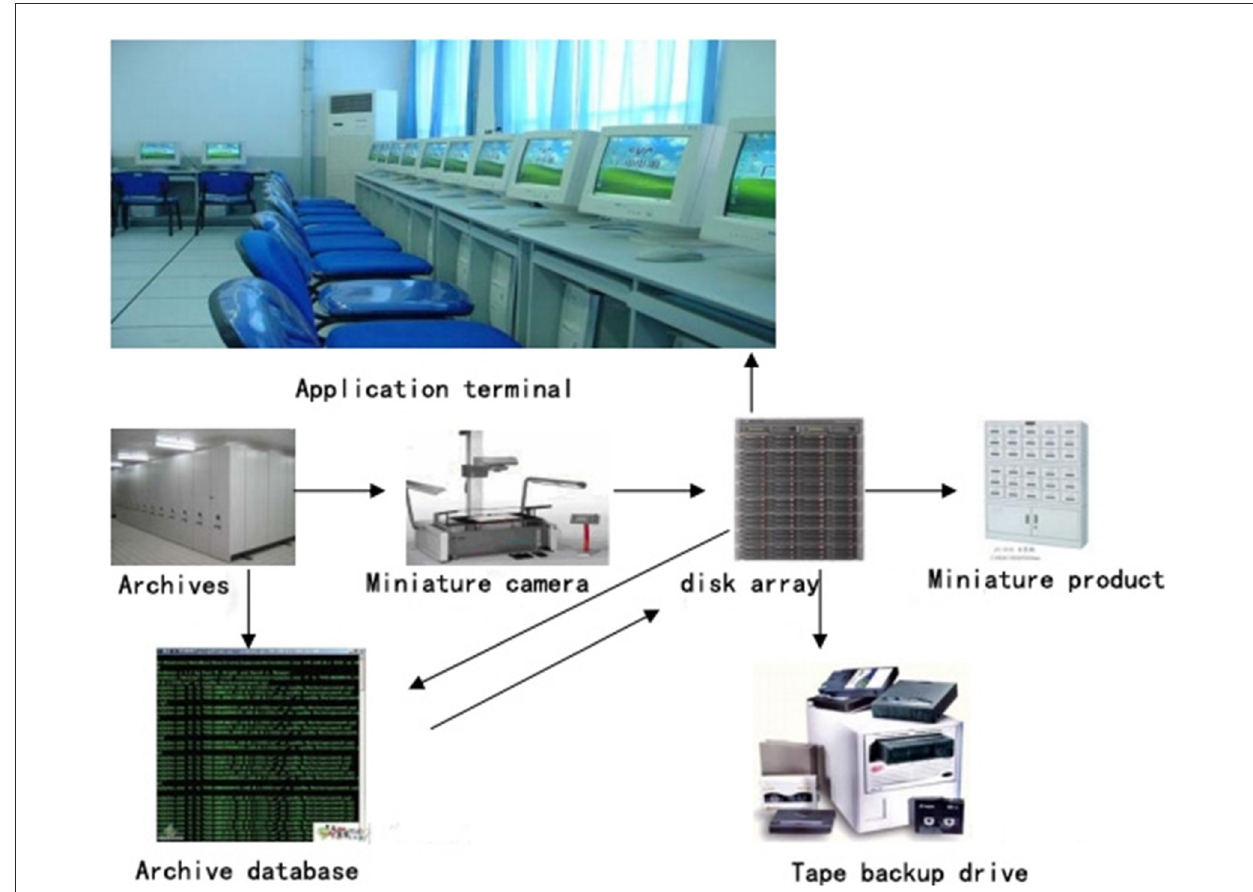
FIGURE2 Hardware configuration structure of digital management system based on micro digital image technology.